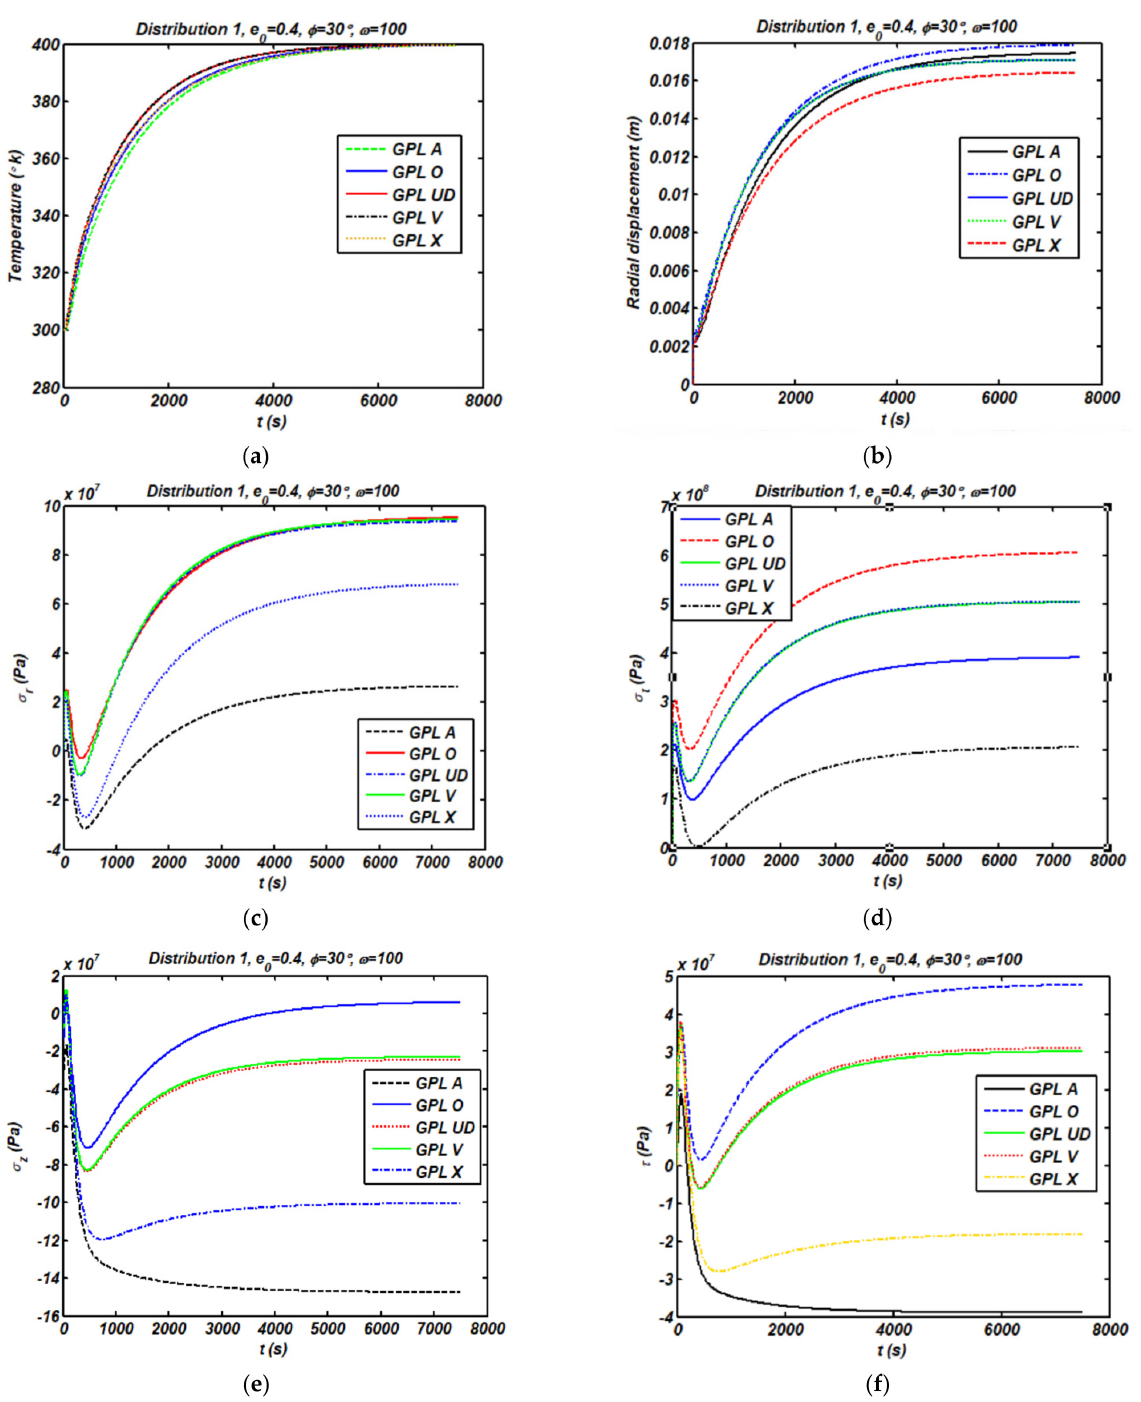
Figure 3. Influence of GPL pattern on the transient temperature ( a ), radial displacement ( b ), and stress state ( c – f ) for a center point of truncated cone (D1; e 0 = 0.4; φ = 30 ◦ ; γ GPL = 0.01; ω = 100 rad/s).